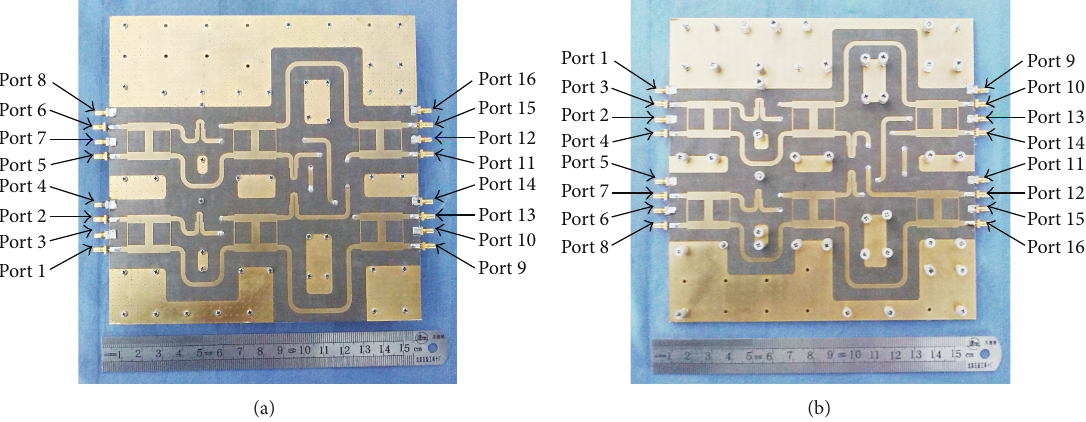
Figure 7: Top (a) and bottom (b) view of the photographs of 8 × 8 Butler matrix sample.